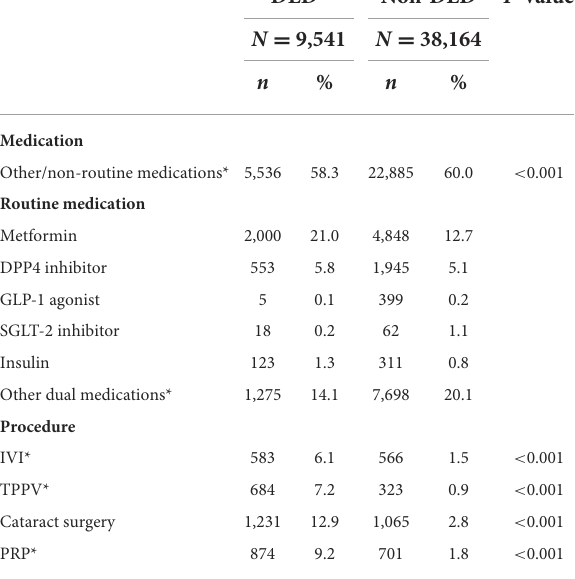
TABLE 3 Hypoglycemic medications used and procedures received in both dry eye disease and non-dry eye disease groups after age and sex match.